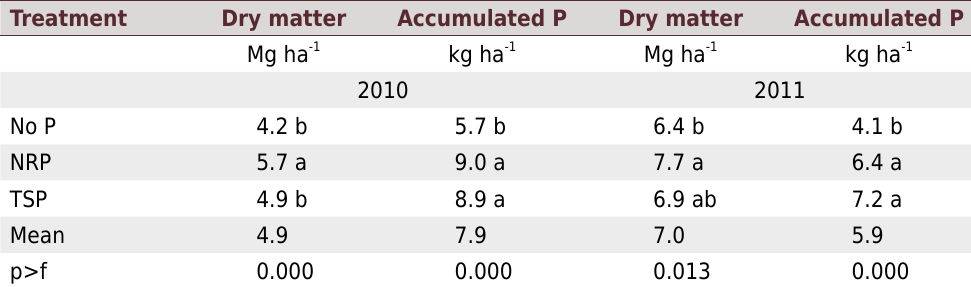
Table 3. Ruzi grass dry matter yields and P accumulation before desiccation, on November 2010 and 2011